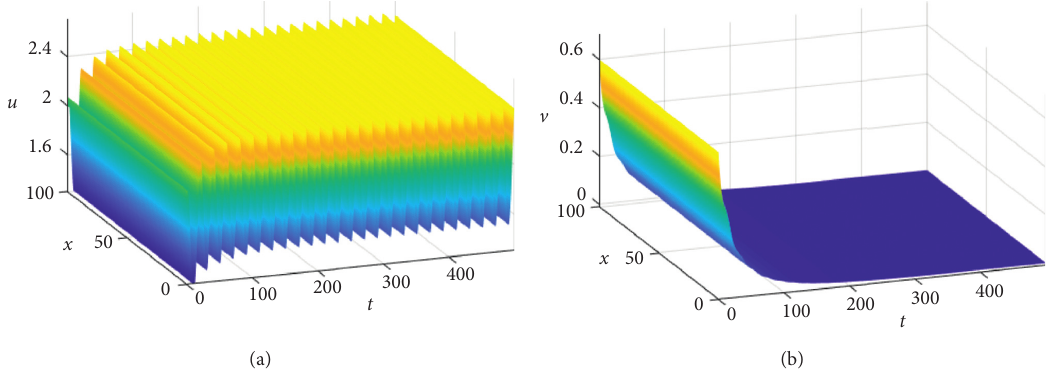
Figure 2: Numerical solutions of system (6a)–(6c): (a) prey population u and (b) predator population v .